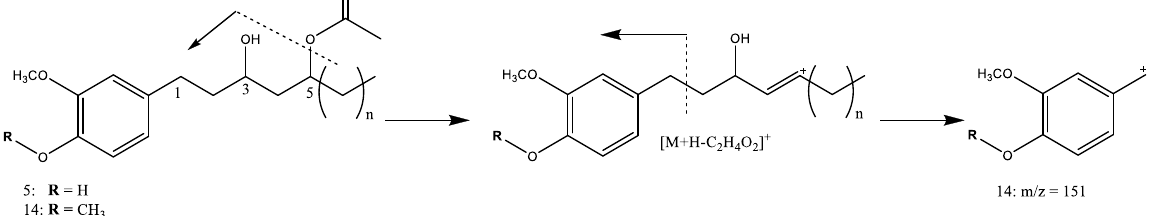
Figure 9. Fragmentation pathway of acetoxygingerdiol 5 ( n = 6) and methyl-acetoxygingerdiol 14 ( n = 6).